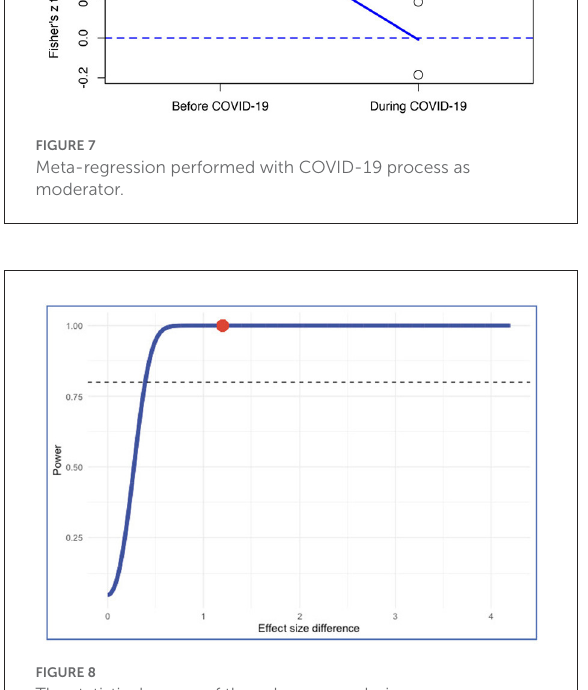
FIGURE8 The statistical power of the subgroup